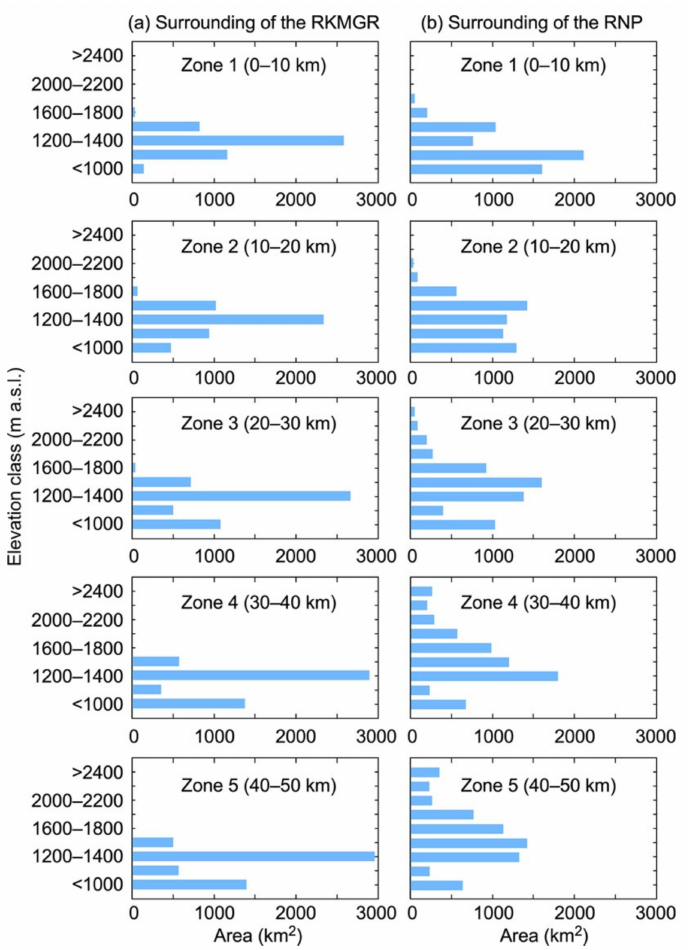
Figure 10. ( a , b ) Distribution of elevation across five zones (as shown in Figure 9) in the surroundings of the Ruaha–Rungwa